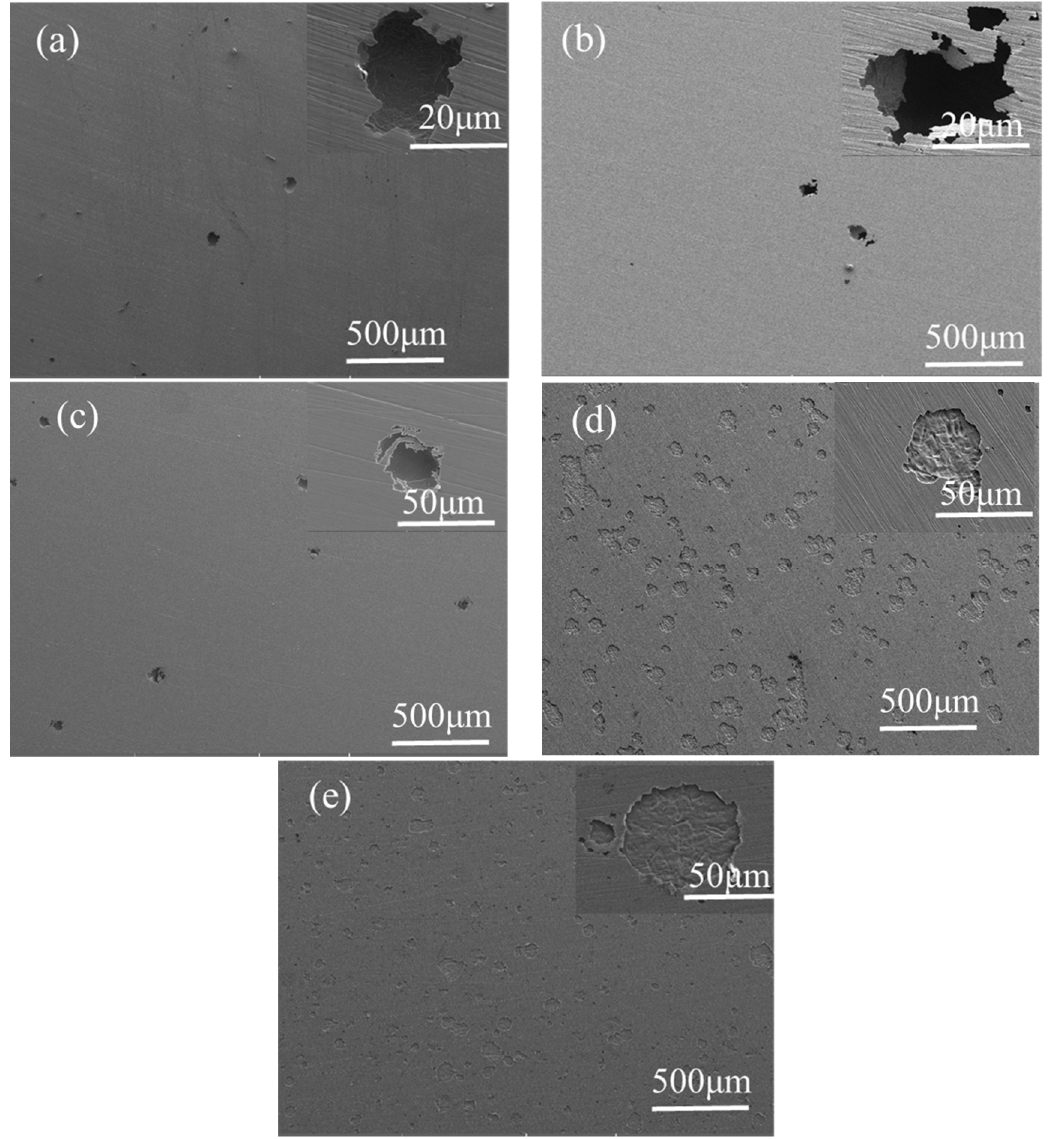
Figure 8. SEM micrographs of 321 stainless steel after polarization under the condition of ( a ) without EHC and a hydrogen charging current density of ( b ) 0.1 mA/cm 2 , ( c ) 1 mA/cm 2 , ( d ) 10 mA/cm 2 , and ( e ) 80 mA/cm 2